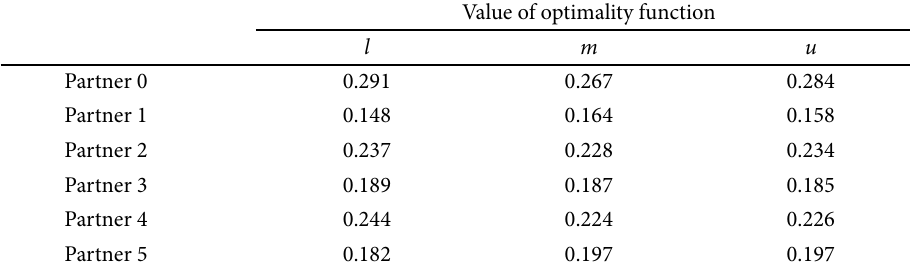
Table 13. The value of optimality function resulting from the ARAS-F method